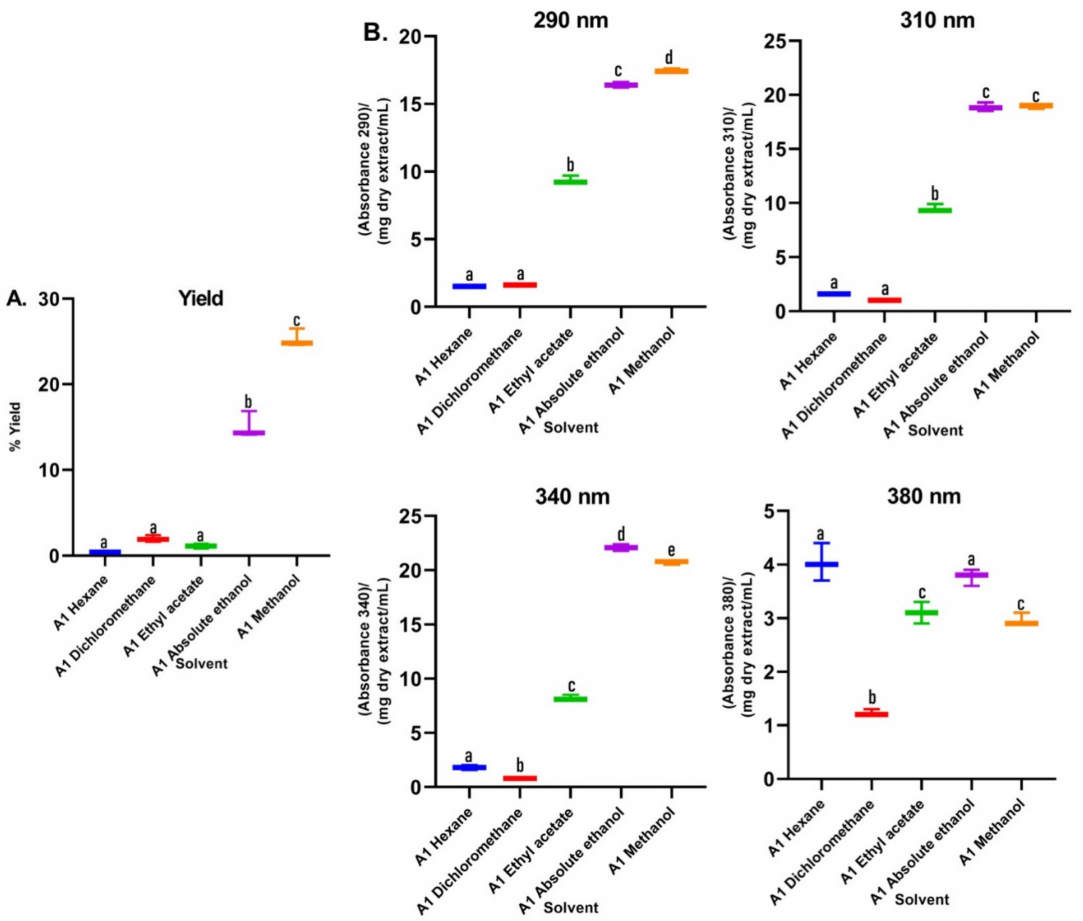
Figure 3. ( A ) Yields of B. antioquensis sequential extractions in different solvents. ( B ) Relative absorption coefficients (RAC) of extracts of B. antioquensis (Assay 1). Values with different letters are significantly different ( p <